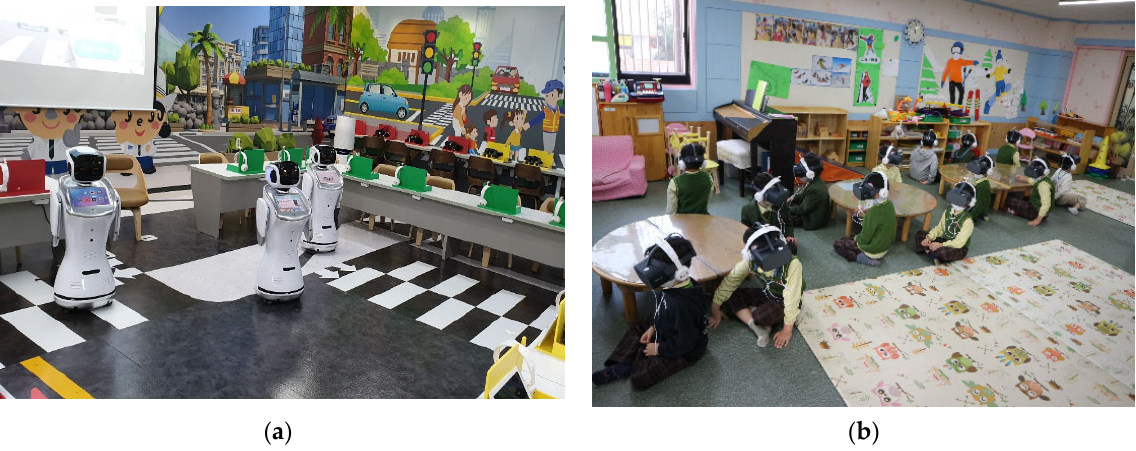
Figure 1. Photograph of the J ‐ City Children’s Traffic Park Virtual Reality Center. ( a ) An intelligent guide robot provides guidance and pre ‐ education to infants. ( b ) Infants wearing VR headsets in the classroom.